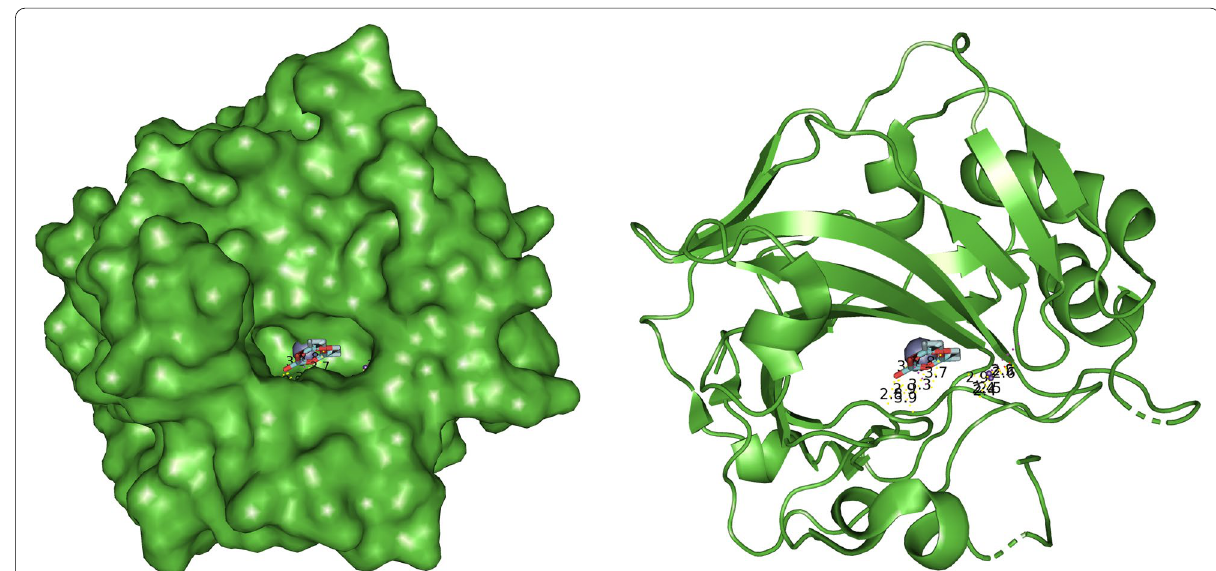
Fig. 9 General overview of the interaction between halogenated boroxine molecule and human carbonic anhydrase IX